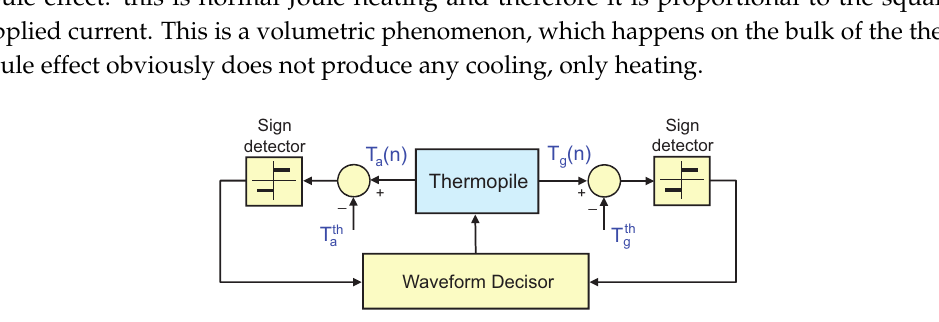
Figure 1. Schematic of the sigma-delta inspired controls. Details on the experimental implementation of this control strategy are provided later in Section